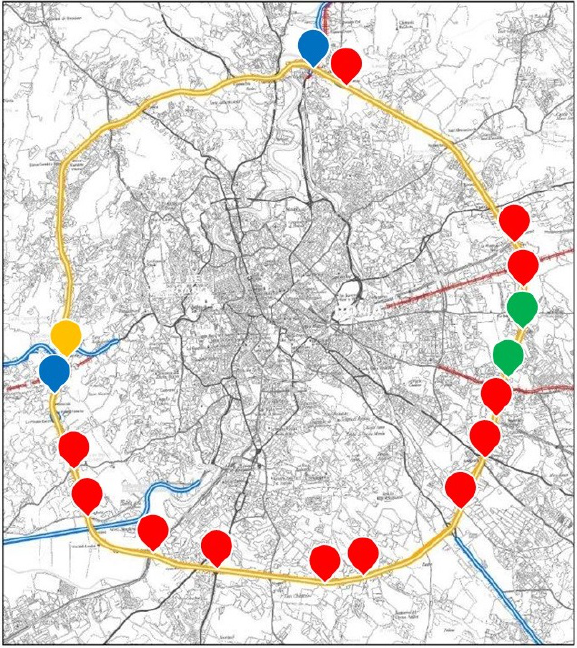
Figure 2: Rome pilot area. Different color codes identify the test sites belonging to the four scenarios: red (scenario A); yellow (sce- nario B); Green (scenario C) and blue (scenario